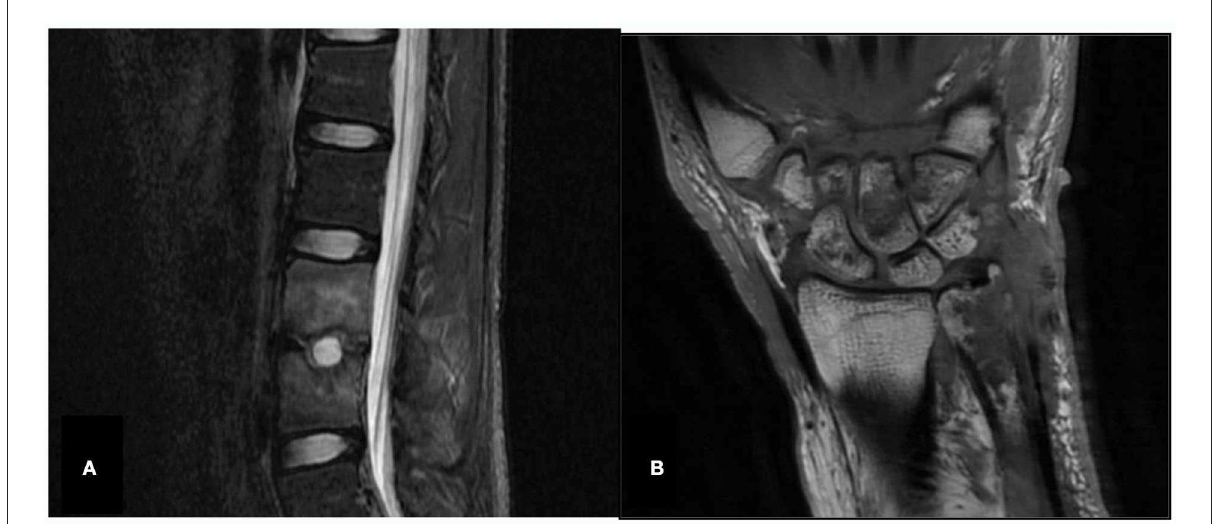
FIGURE1 Spine and joint MRI (Case 10 and Case 18X). (A) Case 10, spinal magnetic resonance imaging (MRI), abnormal signals in the L3 and L4 vertebrae, abscess, narrowing intervertebral space and disappearance of the normal disc signal. (B) Case 18X, left wrist joint MRI, left distal ulna, multiple carpal and metacarpal bone destruction, left wrist joint soft tissue